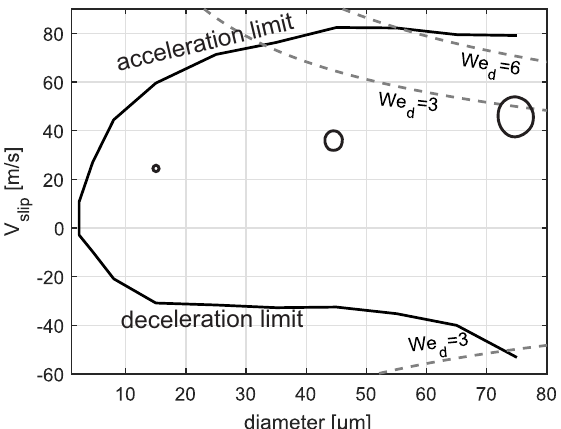
Figure 6. Measured maximum slip velocity range map for droplets at hand. Depicted droplets give an impression of the slip velocity’s influence on the droplets’